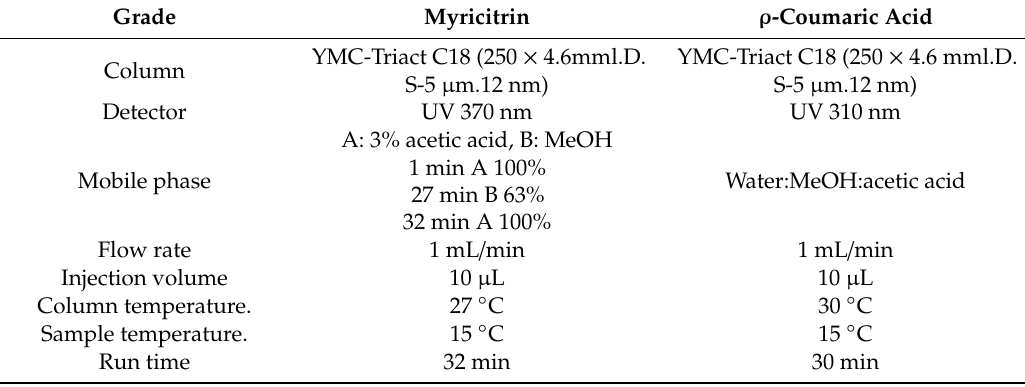
Table 3. HPLC conditions for the separation of hot-water extracts of leaf and branch of S. samarangense